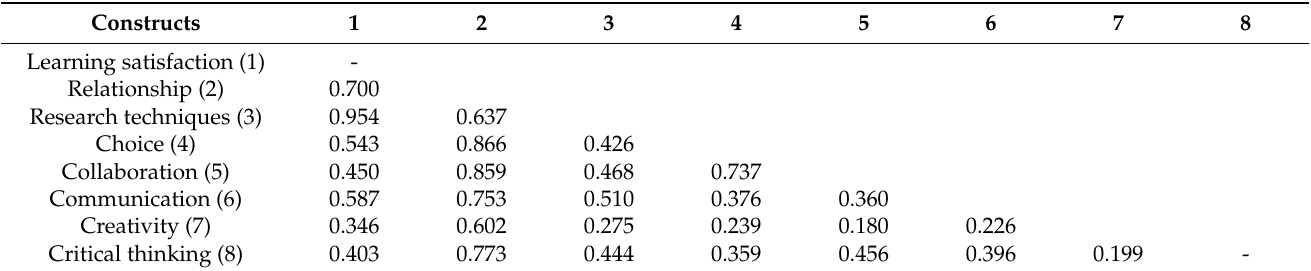
Table 4. Heterotrait-Monotrait Ratio